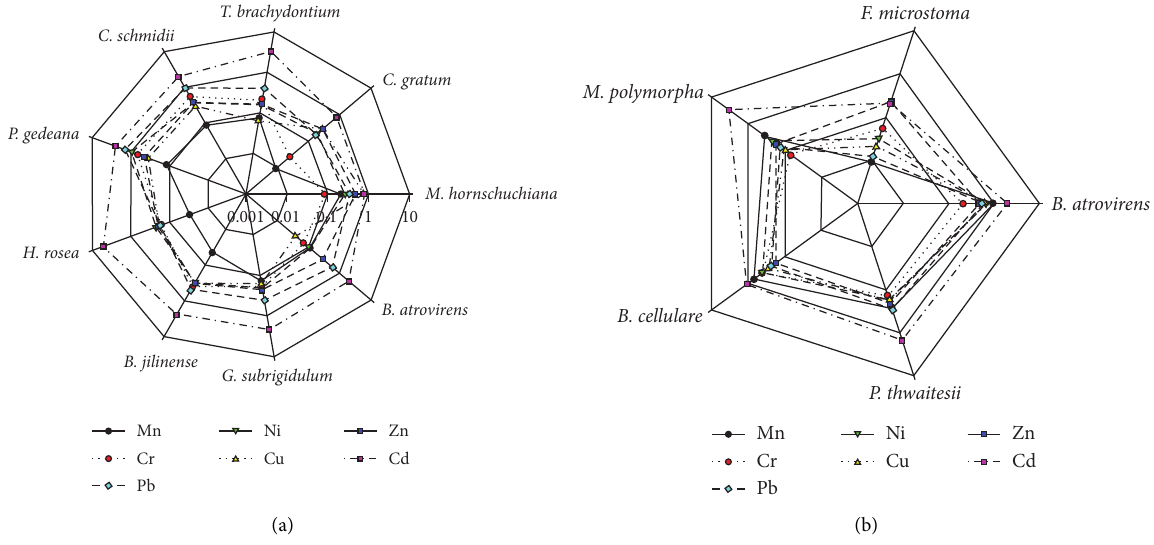
Figure 2: Bioaccumulation factors (BCF) of mosses for heavy metals. (a) The BCF of moss samples collected from mine waste slag areas. (b) The BCF of moss samples collected from electrolytic manganese slag areas. Table 6: The enrichment coefficient of heavy metals in Bryophytes from mine waste areas.